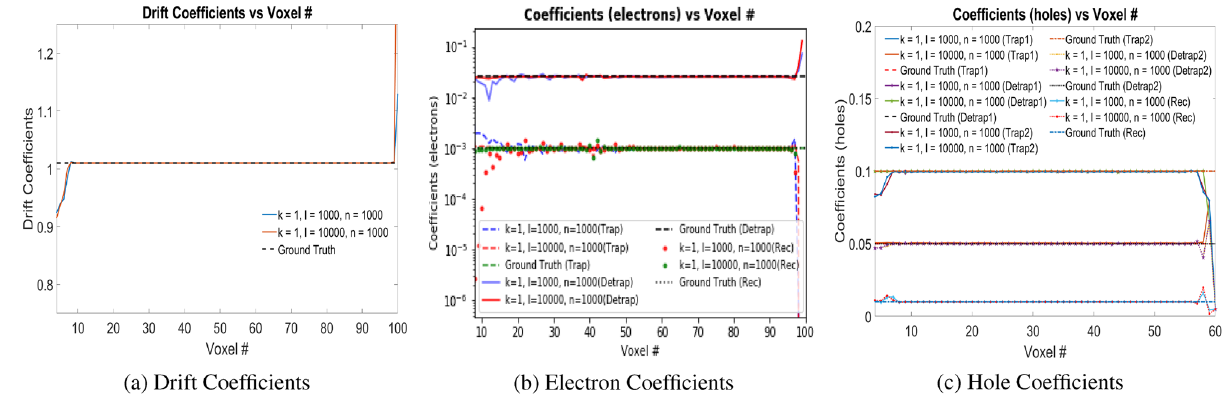
Figure 5. ( a ) Drift coefficients ( µ e ), ( b ) electron coefficients ( w eT , w eD , w eRec ), and, ( c ) hole coefficients ( w hT ,1 , w hD ,1 , w hT ,2 , w hD ,2 , w hRec ) for e–h injection at voxel positions 9 with stride of 5 voxels until voxel 59 for k , l , n in Physical Model-1 as shown in the plot legend. Rec in the legend refers to recombination coefficients. Readers are suggested to enlarge the figure for closer view.